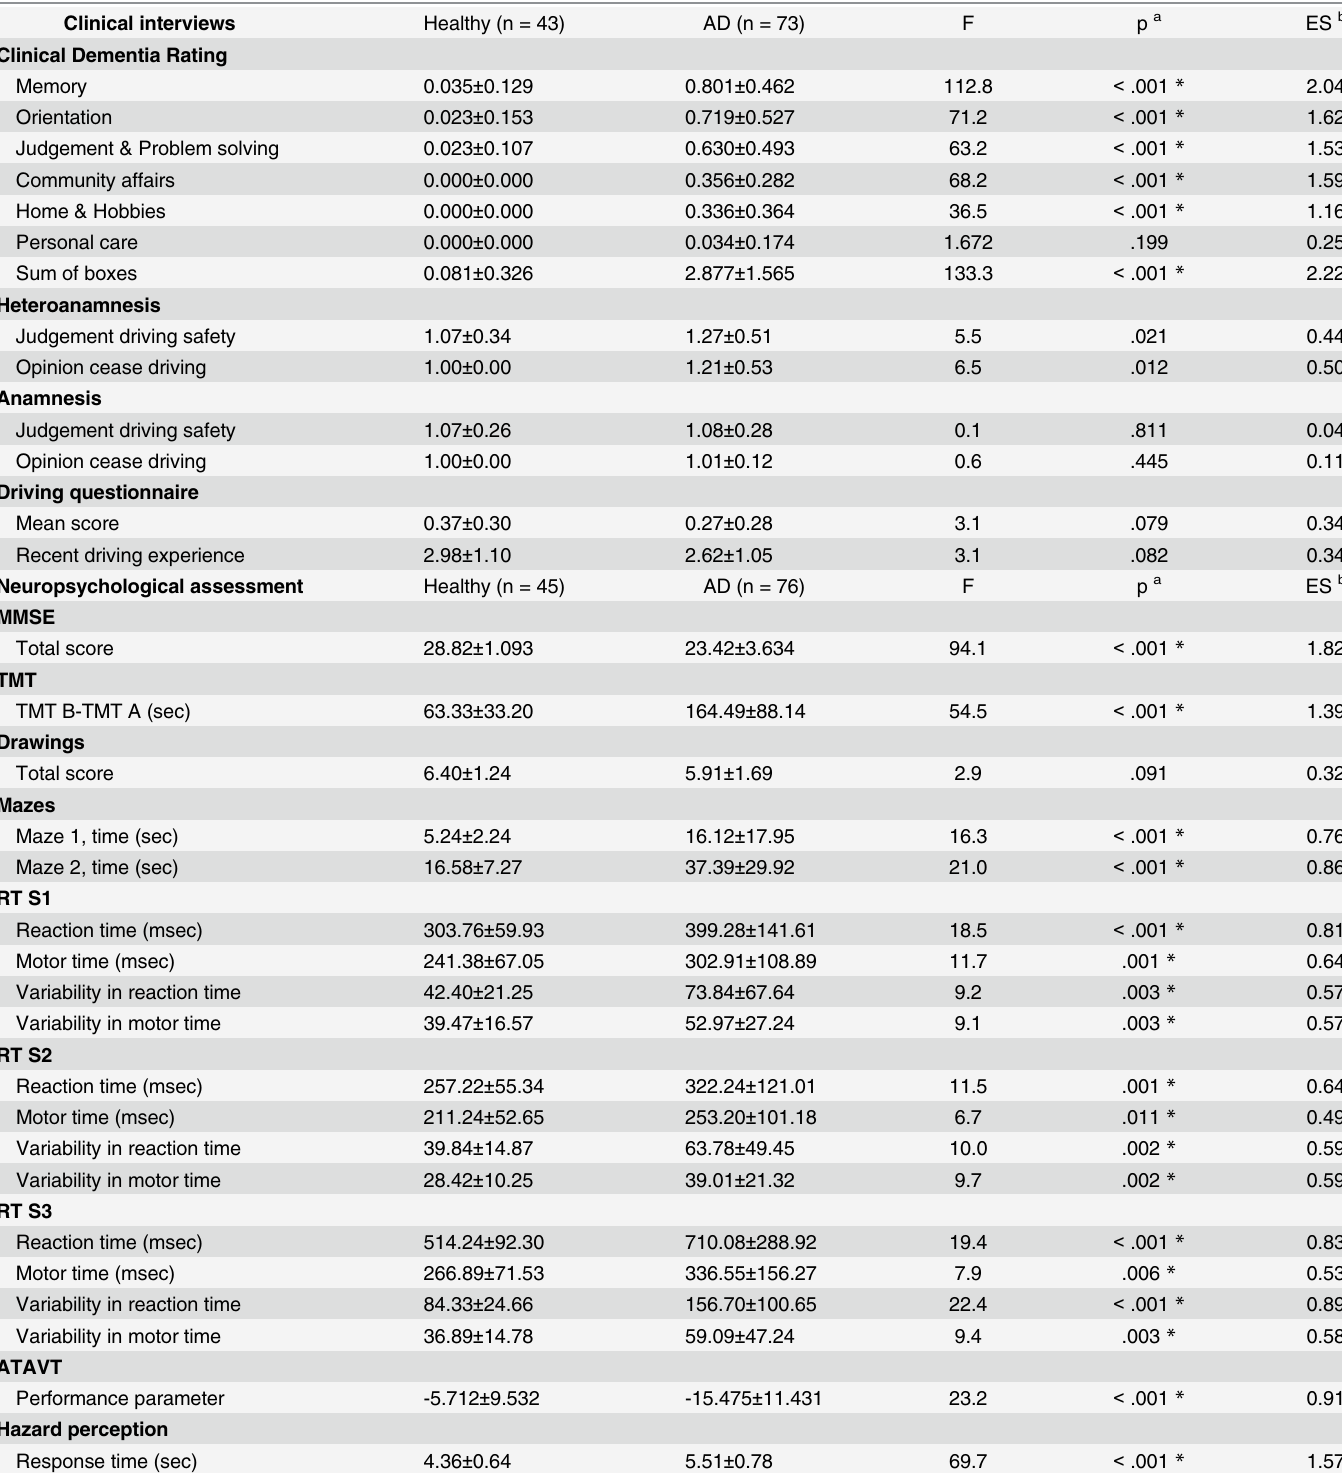
Table 2. Comparison of healthy participants with patients with Alzheimer ’ s disease (AD) on clinical interviews, neuropsychological assessment, and driving simulator